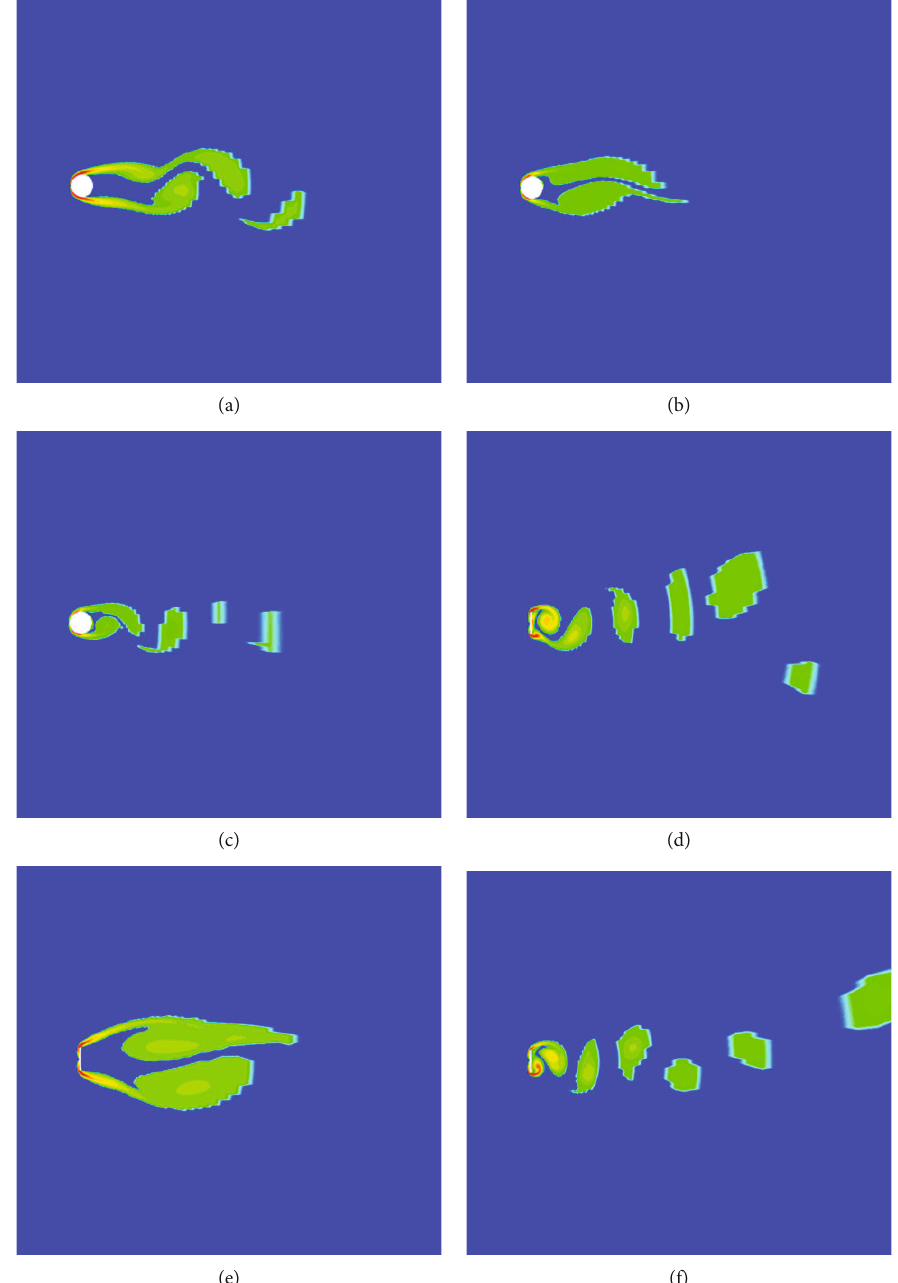
Figure 5: Visualization results of 2D fl ow fi eld training data. Colour map with green and blue denote the vortex region and the nonvortex region. (b, c) The vortical structures in the same cylinder fl ow fi eld on the di ff erent time steps. (e, f) The vortical structures in the same plate fl ow fi eld on the di ff erent time